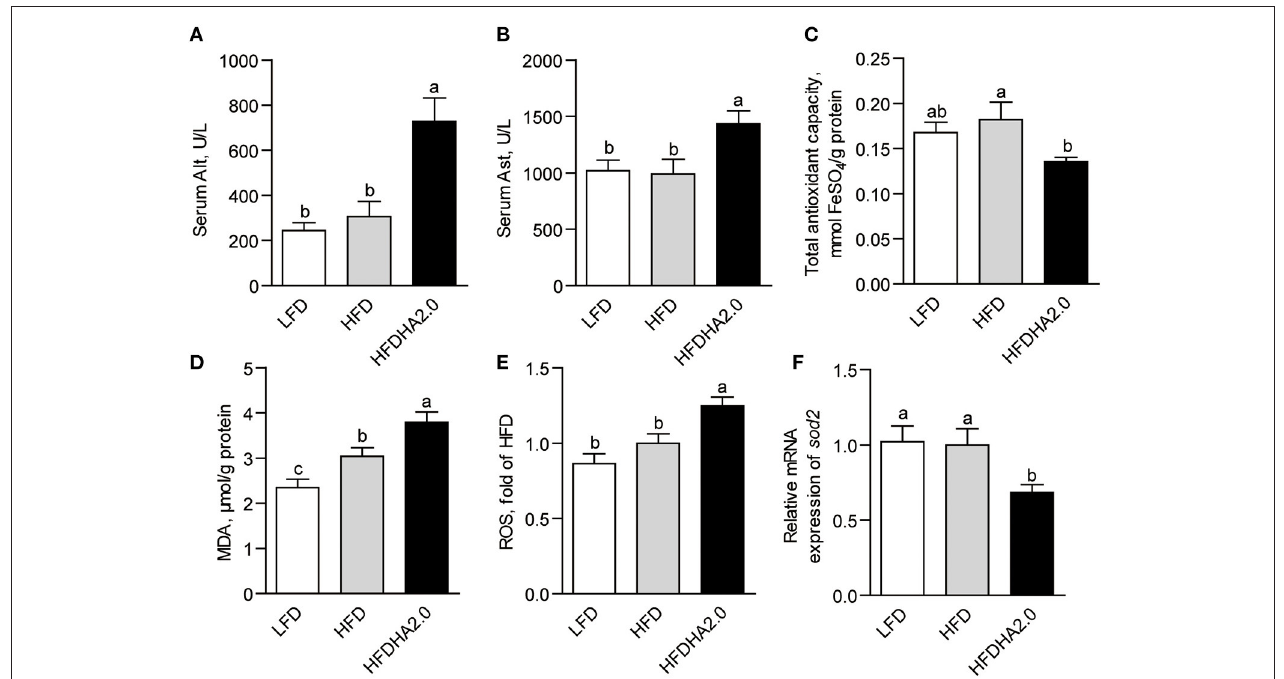
FIGURE 2 | The effects of DHA on liver injury and oxidative stress in zebrafish. The activities of serum (A) Alt and (B) Ast of LFD, HFD or HFDHA2.0-fed zebrafish. Hepatic (C) T-AOC, (D) MDA and (E) ROS of LFD, HFD or HFDHA2.0-fed zebrafish. The relative mRNA expression of (F) sod2 of LFD, HFD, or HFDHA2.0-fed zebrafish. The values are means ± SEMs ( n = 5 or 6 biological replicates). The mean values without a common letter are significantly different, p < 0.05. LFD, low-fat diet; HFD, high-fat diet; HFDHA2.0, 2% DHA-supplemented HFD.